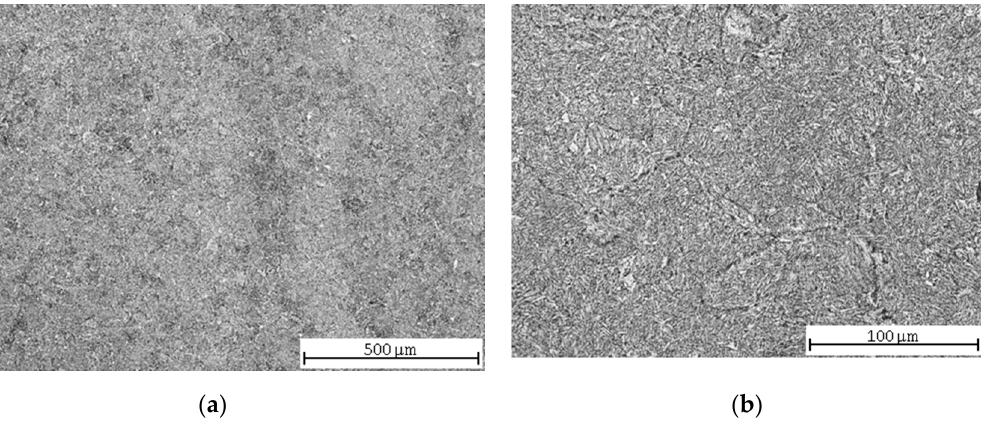
Figure 8. Quenched and tempered 37MnSi5 steel microstructures: ( a ) central part; ( b ) detail.